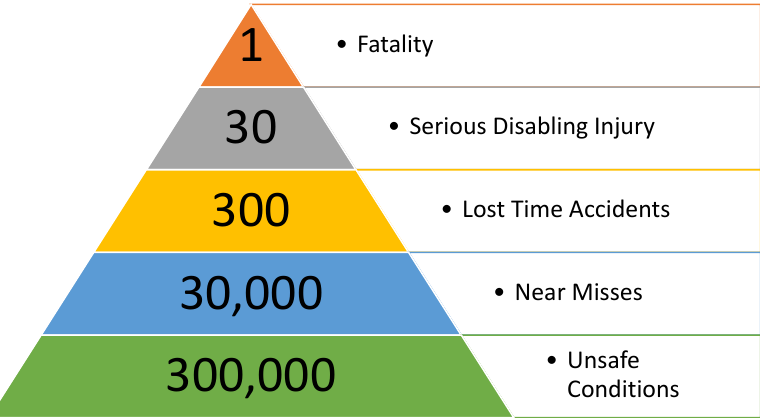
Figure 7. Safety Pyramid, authors’ own elaboration based on [41].